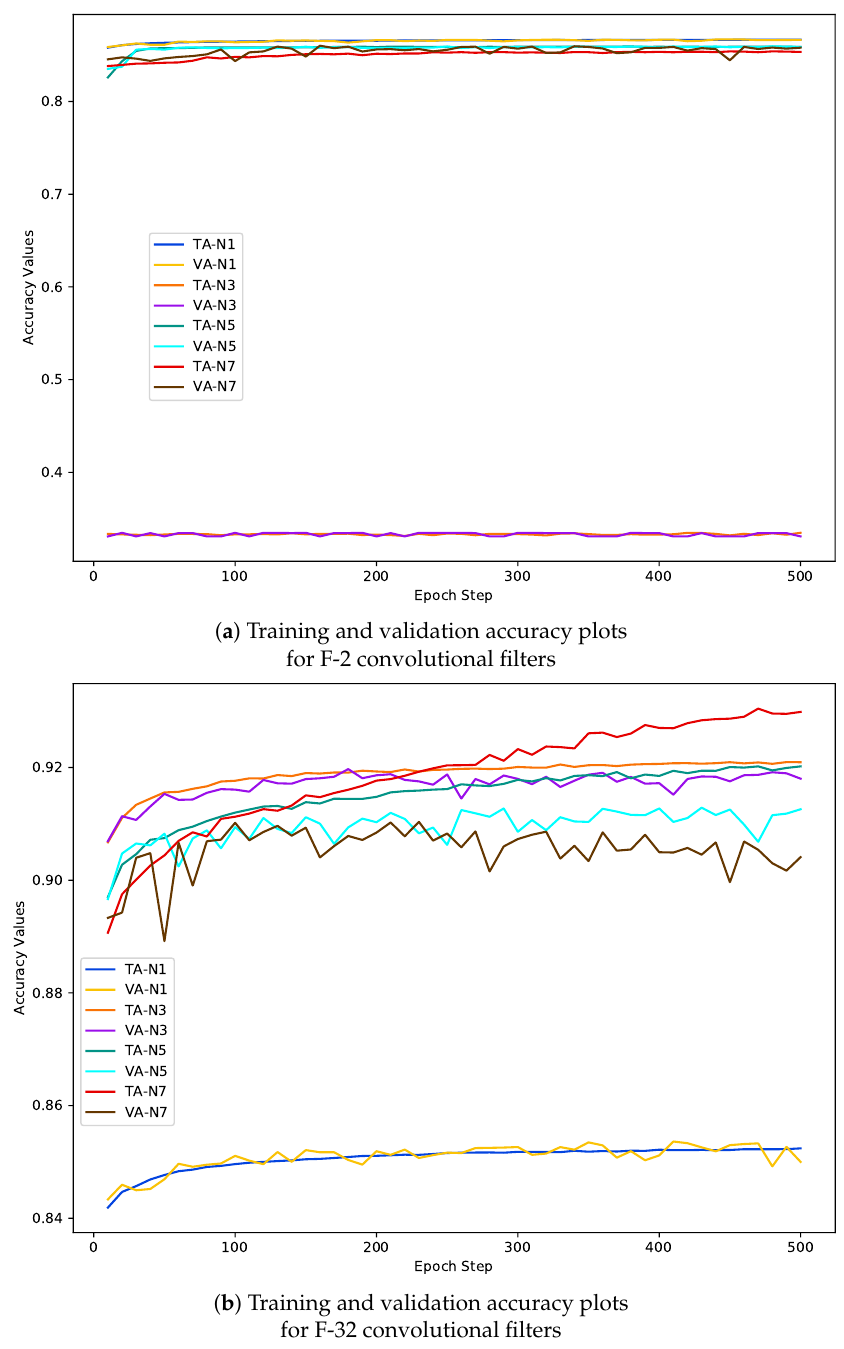
Figure 7. Training and validation accuracy plots of model networks with combinations of different numbers of convolutional filter and different sets of training sample. The number of learnable filters used to the model is specified as ‘F-number’ in every sub-caption. TA and VA in legends denote training accuracy and validation